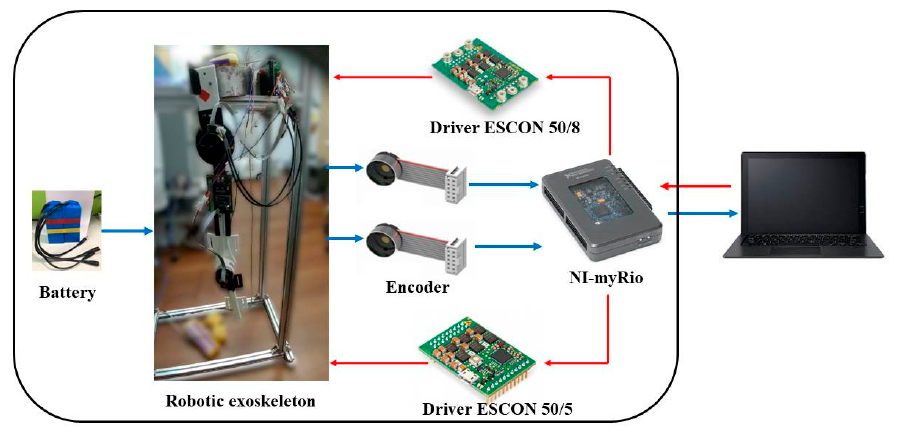
Figure 2. Control circuit and